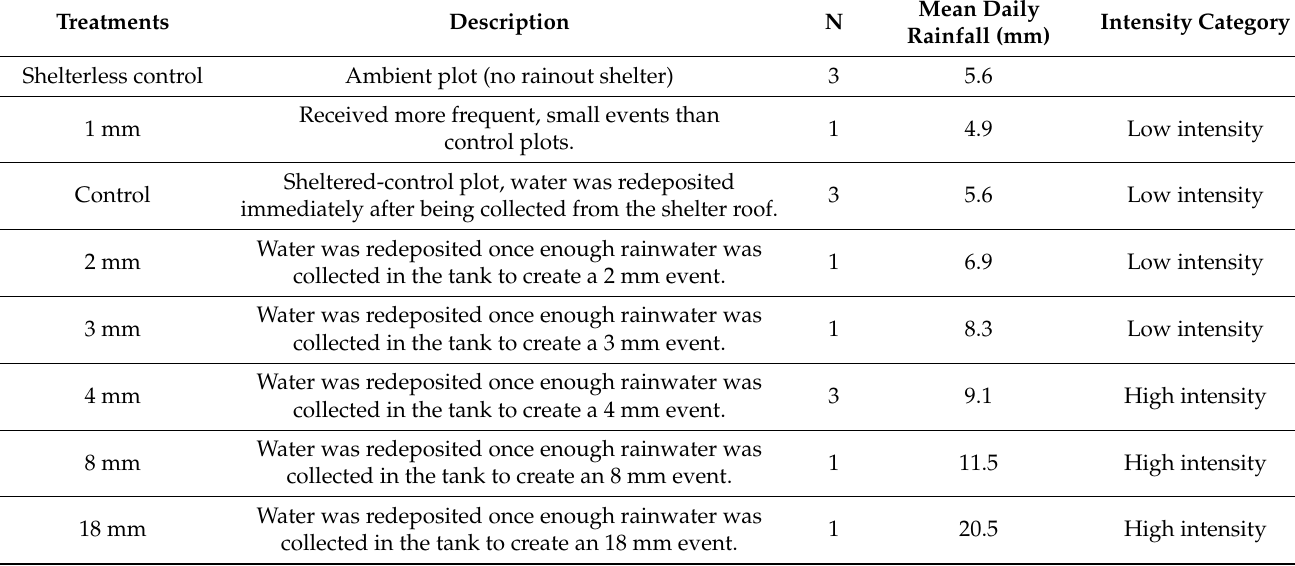
Table 1. Treatment descriptions, number of replicate plots (N), and the mean daily rain on days with rainfall. All treatments received the same total water and only differed in event size and frequency. Treatment names were based on event sizes, that is, the amount of water that would be collected from shelter roofs and accumulate in the tanks before being redeposited. Mean daily rain on days with >0 mm of rain was calculated using observed rainfall during the experiment (Appendix B; Figure S3). These values are larger than the event sizes because when large natural rain events occurred, water would be redeposited onto the plot multiple times in one day (i.e., multiple “events” in 1 day). The “intensity category” grouped treatments into low- and high-precipitation-intensity categories that were used in the analyses. Shelterless control plots were not included in the analyses of treatment effects but were used to assess shelter effects. Treatments